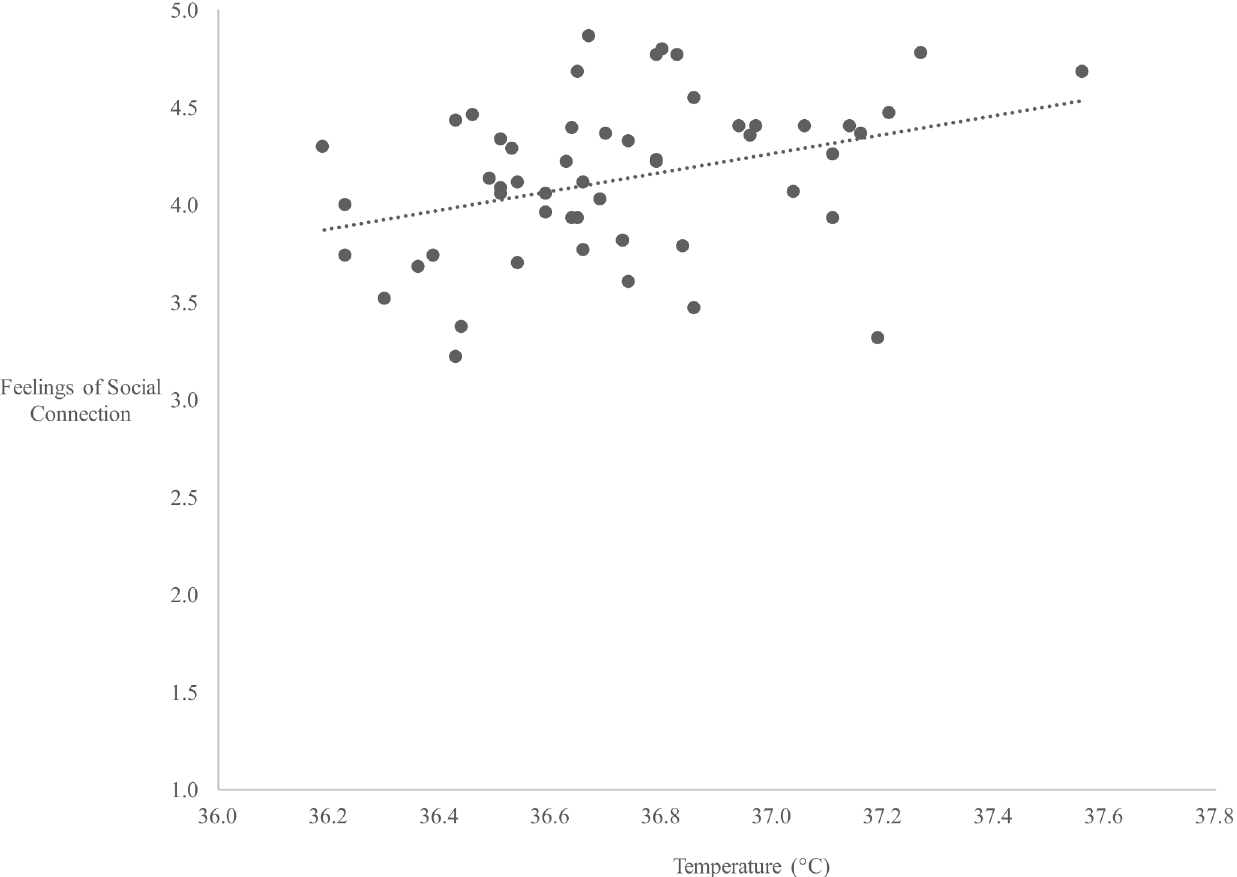
Fig 1. Association between oral temperature and feelings of social connection. Oral temperature was positively correlated with feelings of social connection such that higher temperatures (in the non-febrile range) were associated with greater reports of social connection over a 7-hr study